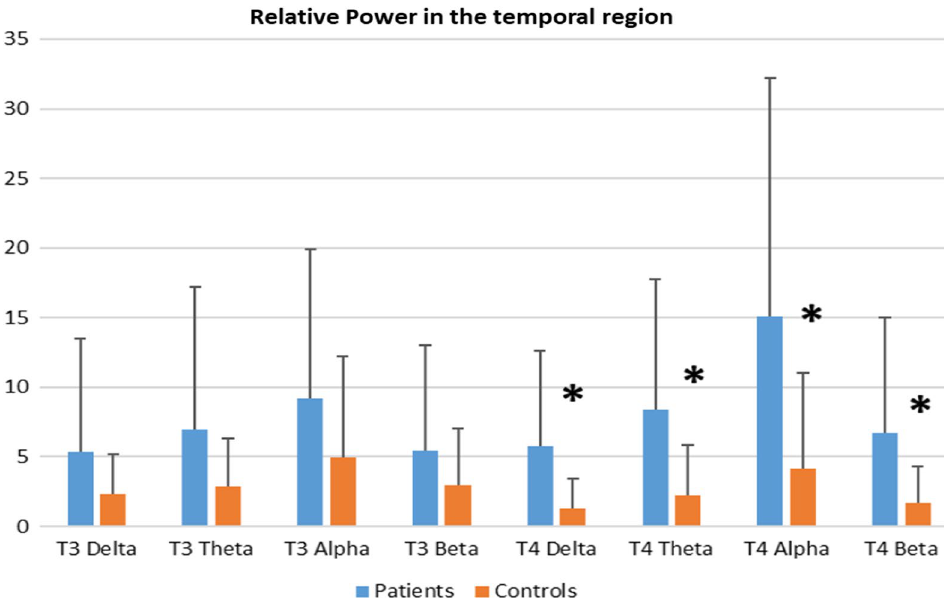
Fig. 1 Relative power in bilateral temporal regions of the patients and controls